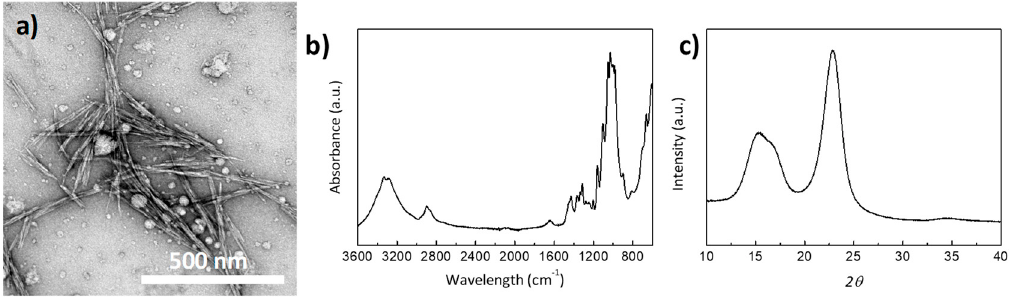
Figure 1. ( a ) Representative TEM images, ( b ) FTIR spectrum, and ( c ) XRD pattern of cellulose nanocrystals (CNCs).